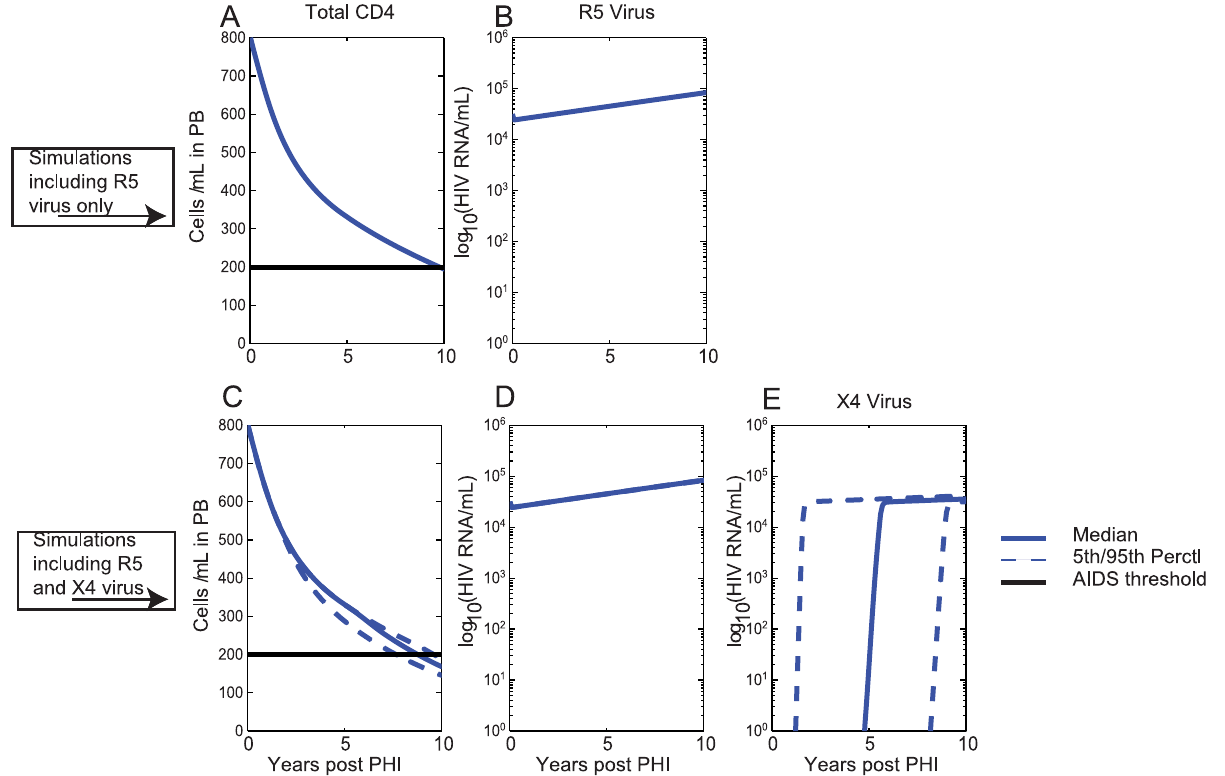
Figure 2. Progression of untreated HIV infection over a 10-year period. Here year 0 denotes the end of primary HIV infection (PHI). Solid lines denote median values, dashed lines denote the 5 th and 95 th percentile ranges. Also shown is the AIDS threshold of 200 cells/ m L (solid horizontal black line); A) Total CD4 + T cell count and B) R5 Viral Load for a single simulation of untreated infection with R5 virus only (i.e. assuming V X 4 t ð Þ ~ 0 throughout the course of infection); C) Total CD4 + T cell count, D) R5 Viral Load and E) 6 4 Viral Load for Monte Carlo simulations (100 trials) of untreated infection assuming initial infection with R5 virus, but now including 6 4 virus.